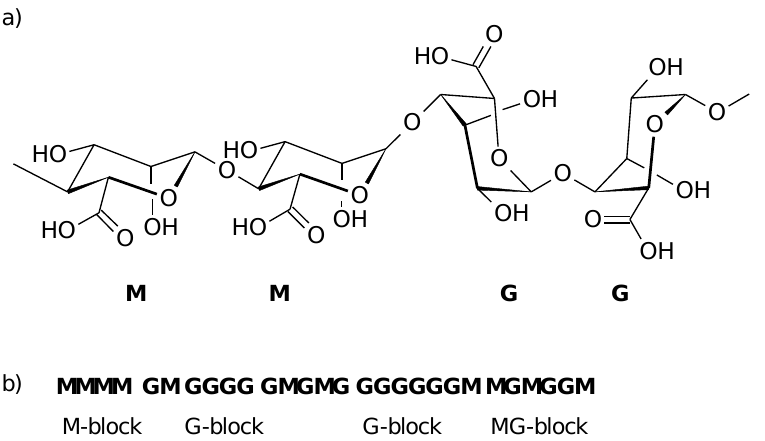
Figure 1. Structure of alginates: ( a ) conformation of the oligosaccharide chain; ( b ) distribution of M and G blocks in the polysaccharide chain.